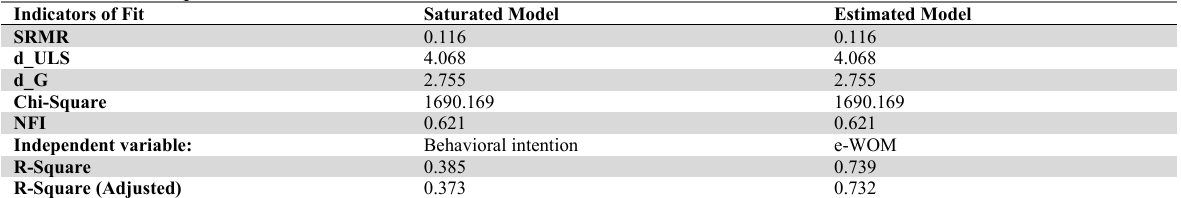
Fit Model and R-Square Indicators of Fit